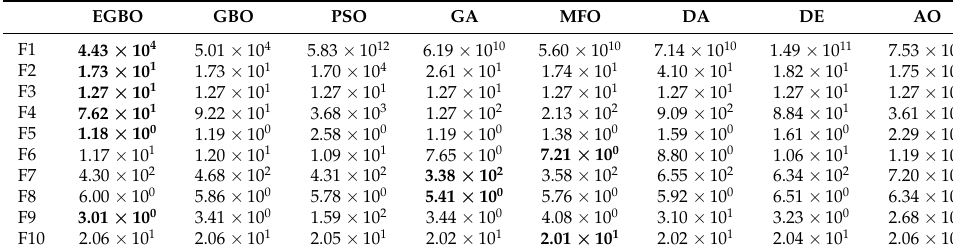
Boldface indicates the best result.